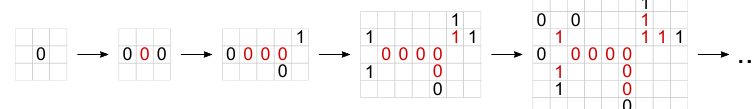
Figure 11: An example of a shielding structure construction. We iteratively ensure inertness of each spin by adding new appropriate spins in its surrounding. This is repeated until the structure “closes onto